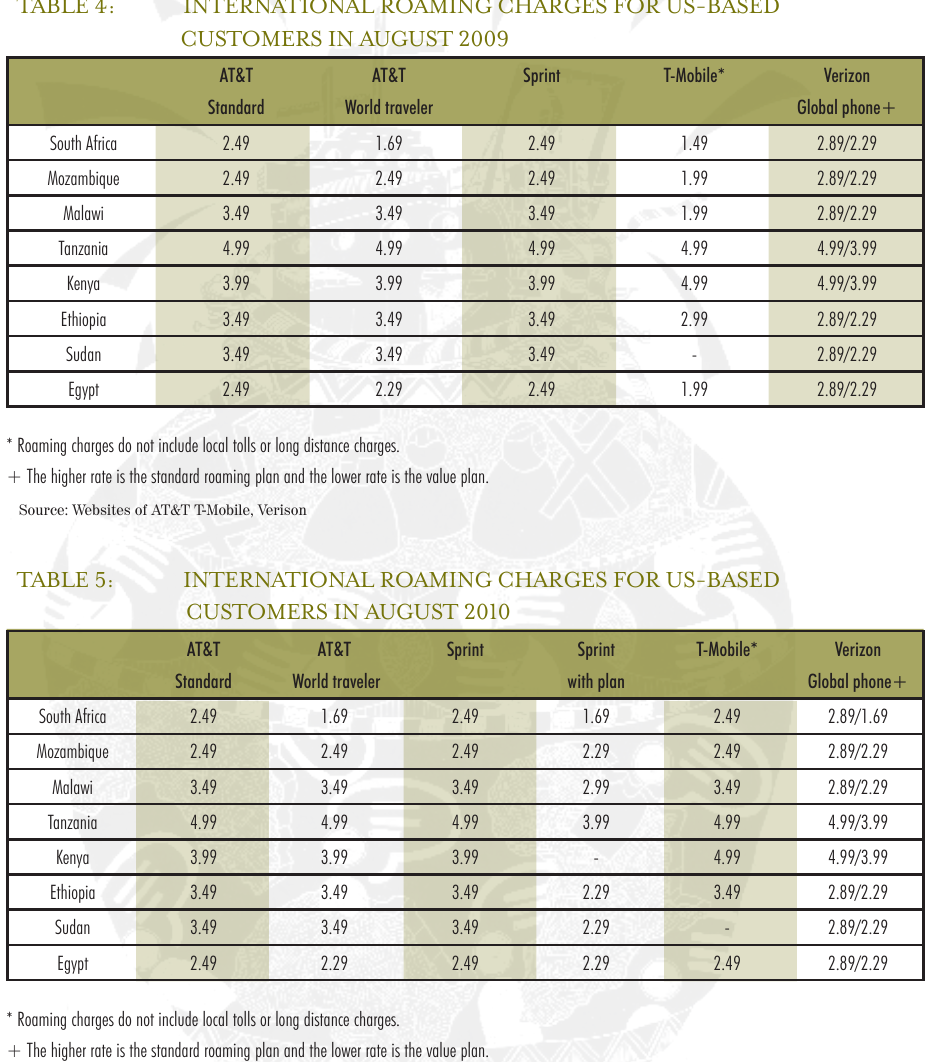
INTERNATIONAL ROAMING CHARGES FOR US-BASED